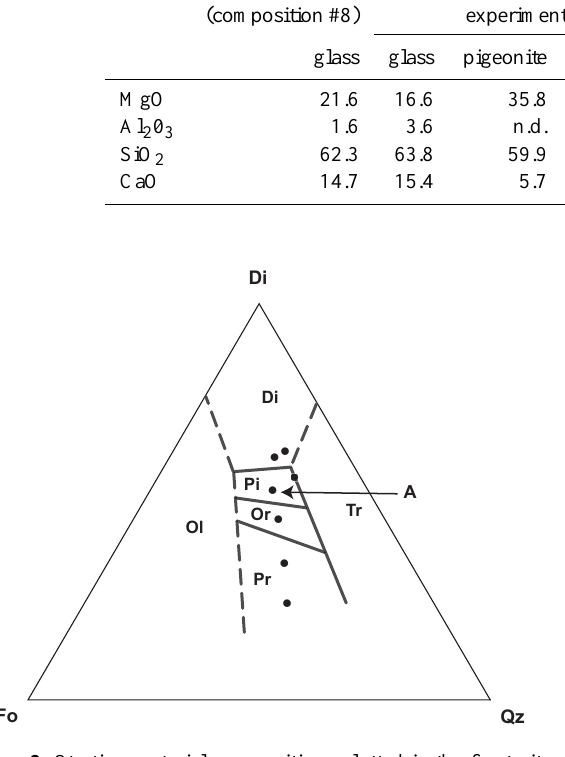
Figure 3. Starting material compositions plotted in the forsterite– Fig. 3. Starting material compositions plotted in the forsterite (Fo) diopside–silica (Fo–Di–Qz) pseudo-ternary diagram. Liquid com- - diopside (Di) - silica (Qz) pseudo-ternary. Liquid compositions positions are projected from anorthite. Phase boundaries and reac- are projected from anorthite. Phase boundaries and reaction tion curves are shown in more detail in Fig. 4. Composition A was curves are also shown from Figure 4. Composition A was used in dynamic crystallization experiments. used in dynamic crystallization experiments.